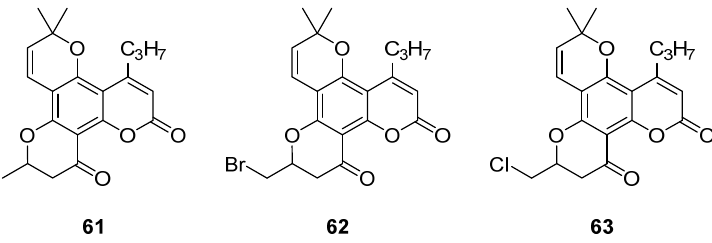
Figure 10. Synthetic calanolide A analogs with anti-HIV activity.